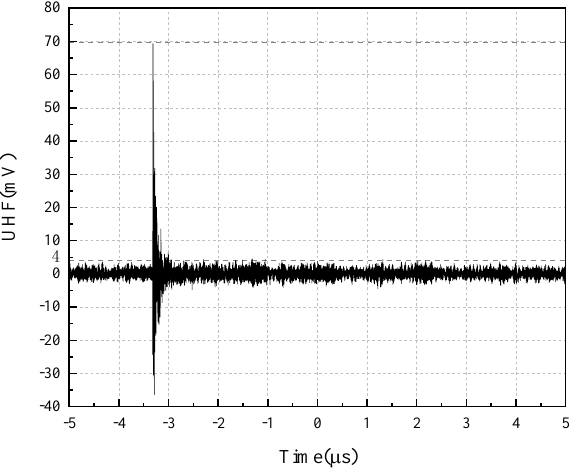
Figure 19. Built-in experimental PD signal waveform.